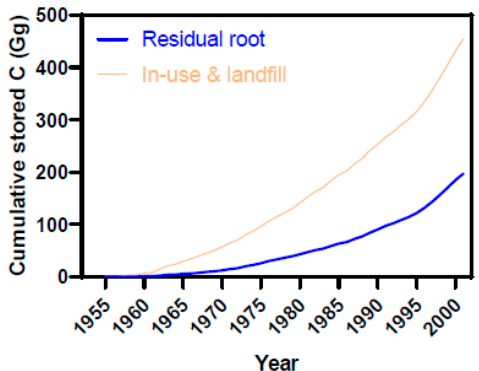
Figure 4. Cumulative stored carbon (C) remaining at the Savannah River Site in 2001 from residual root systems remaining after the harvest (thick dark line) and from in-use and landfill deposits (thin light line).